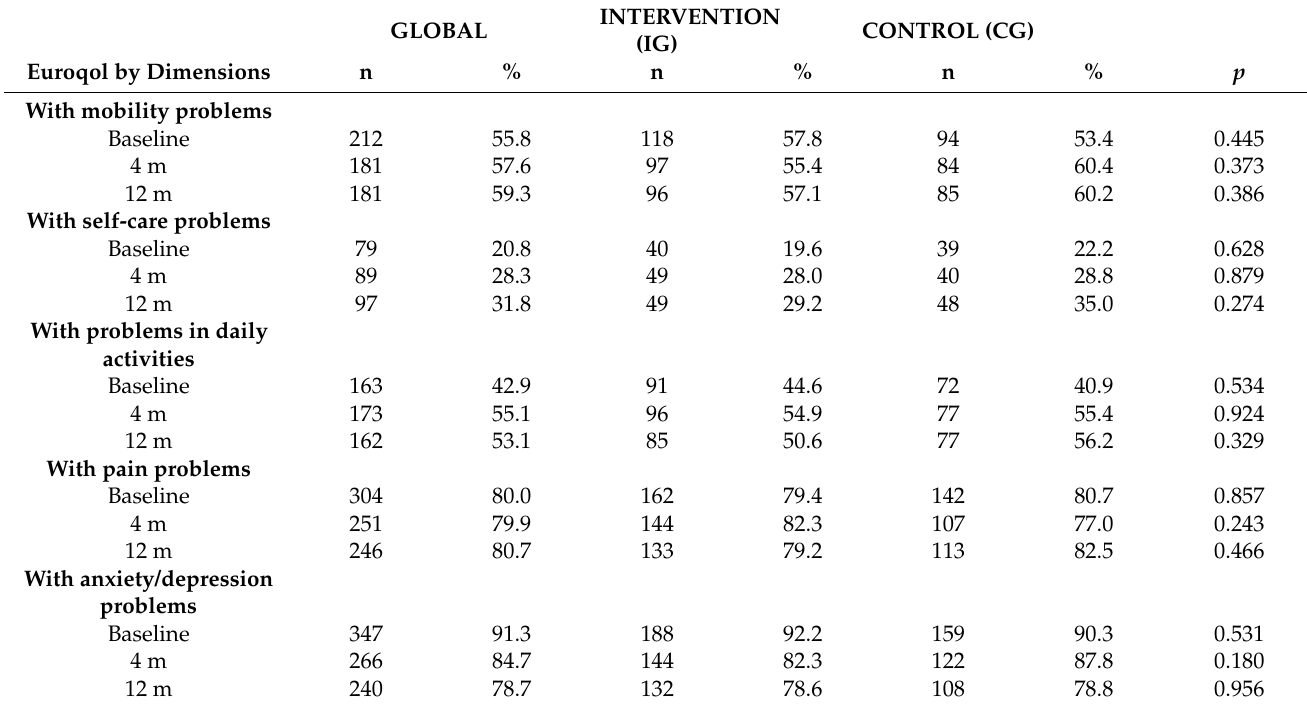
Table 4. EQ-5D dimensions for intervention group and control at baseline, 4 months, and 12 months. GLOBAL